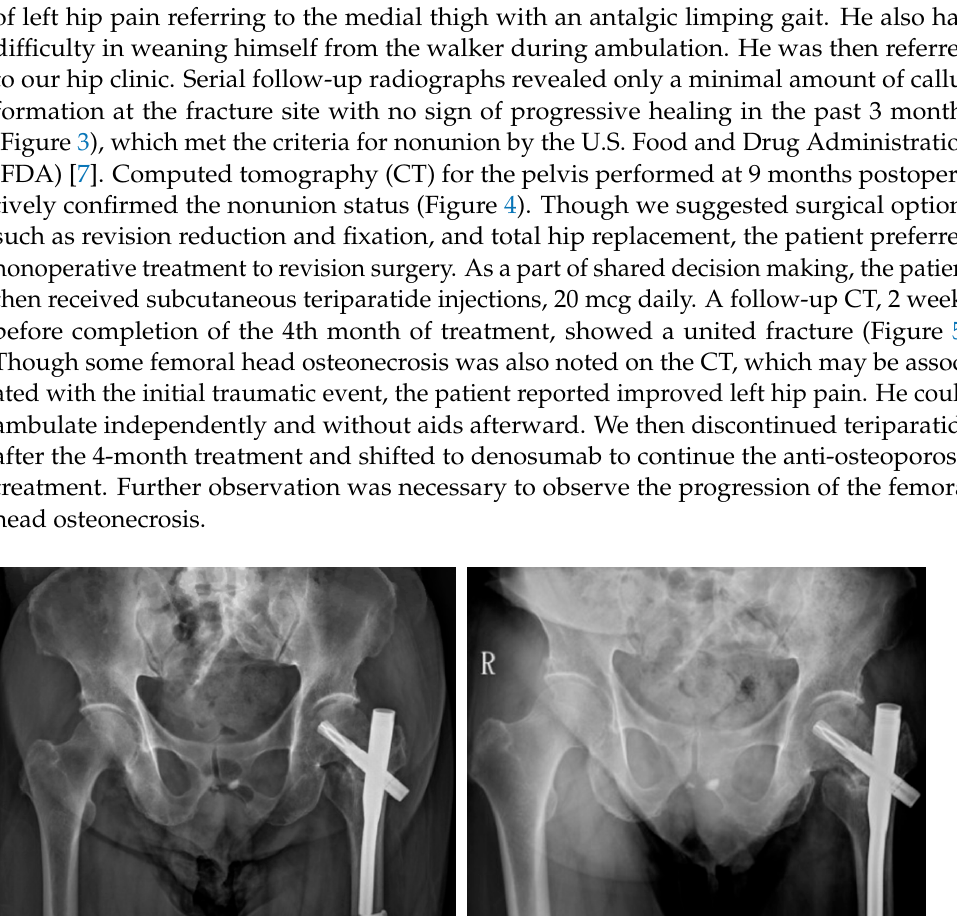
Figure 2. ( A , B ) Orthogonal views of postoperative radiographs, showing varus alignment and neck shortening.